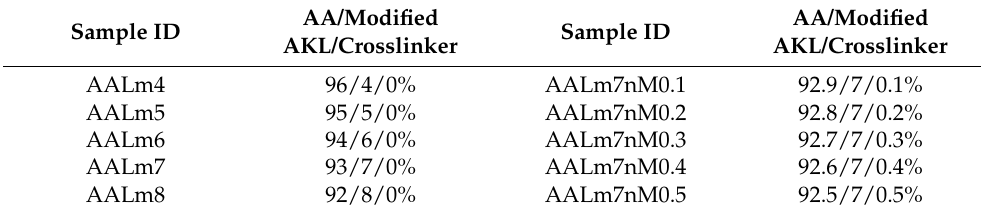
Table 1. Mass ratios of synthesized hydrogels of AA/modified